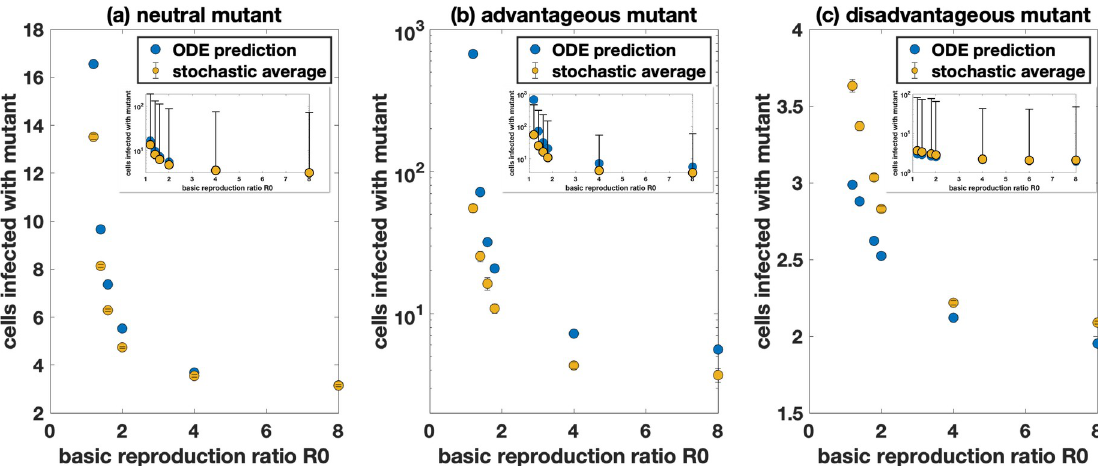
Fig 1. Comparison of the deterministic prediction and stochastic average of the number of cells infected with the mutant with free virus transmission only. The deterministic predictions are in blue and the stochastic hybrid simulations with M ¼ 10 4 (infected populations always treated completely stochastically) are in yellow. Standard error bars are included in the main panel (sometimes too small to see) and the inserts show standard deviation bars. A Neutral mutant, F mutant = 0.9. Each yellow dot represents the average taken over at least 2 × 10 6 simulations. B Advantageous mutant with 10% advantage, F mutant = 0.99. Each yellow dot represents the average taken over at least 1.1 × 10 3 simulations. C Disadvantageous mutant with 10% disadvantage, F mutant = 0.81. Each yellow dot represents the average taken over at least 3.5 × 10 6 simulations. We have R ¼ l ð b F þ g ð 1 (cid:0) ð 1 (cid:0) F Þ S ÞÞ , and the parameters are F wild-type = 0.9, N = 3, μ = 3 × 10 − 5 , λ = 1.59 × 10 7 , β 0 ad = 4 × 10 − 9 , γ = 0, and d = 0.016. The infected cell death rate a is adjusted to achieve the required R 0 .